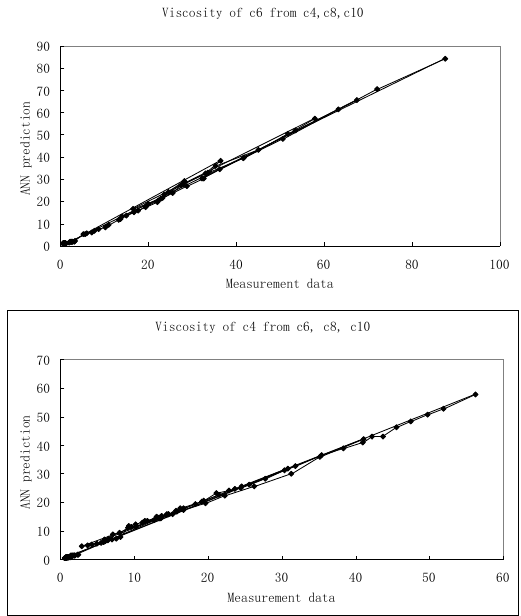
Fig. 5.6 A scatter plot as an evaluation of ANN performance for [C n -mim][NTf 2 ]-ethanol mixture with n =4, 6, 8,